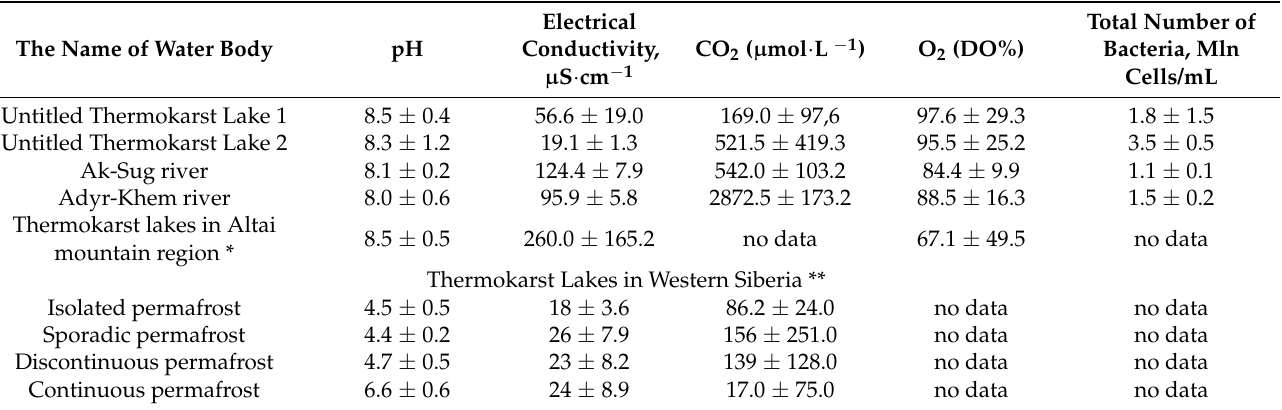
Table 2. Р hysico-chemical and microbiological characteristics of lake and river